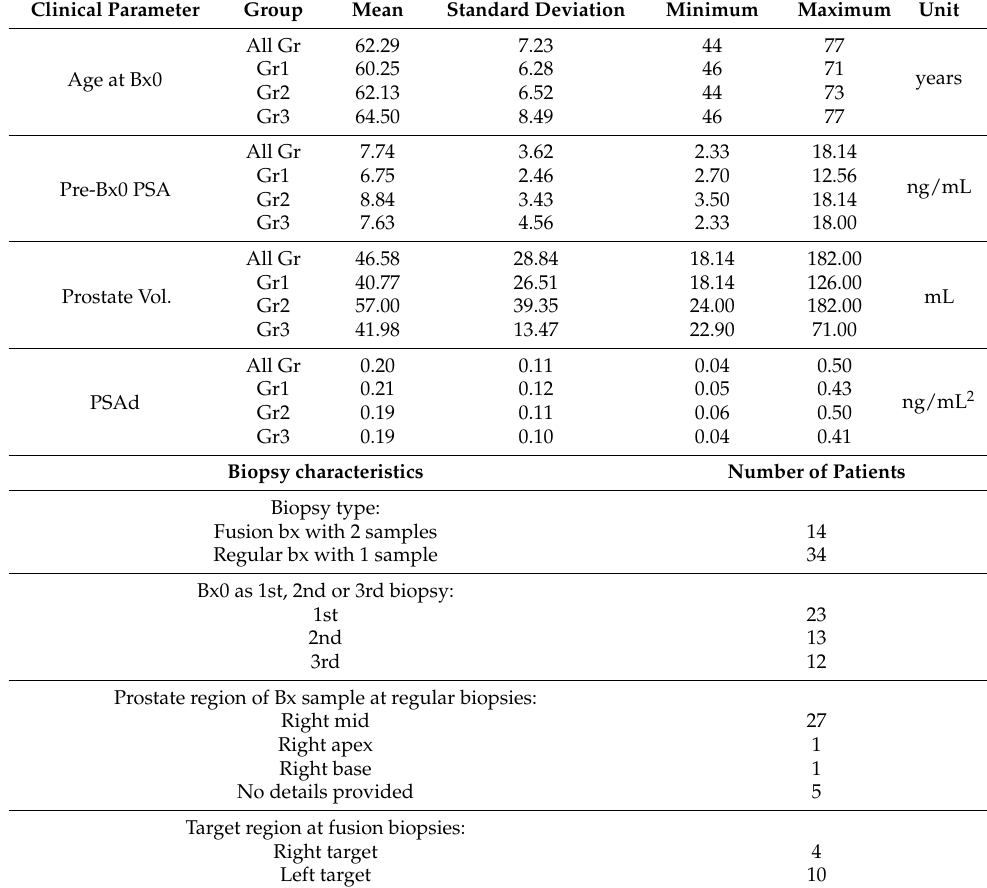
Table 1. Baseline characteristics at